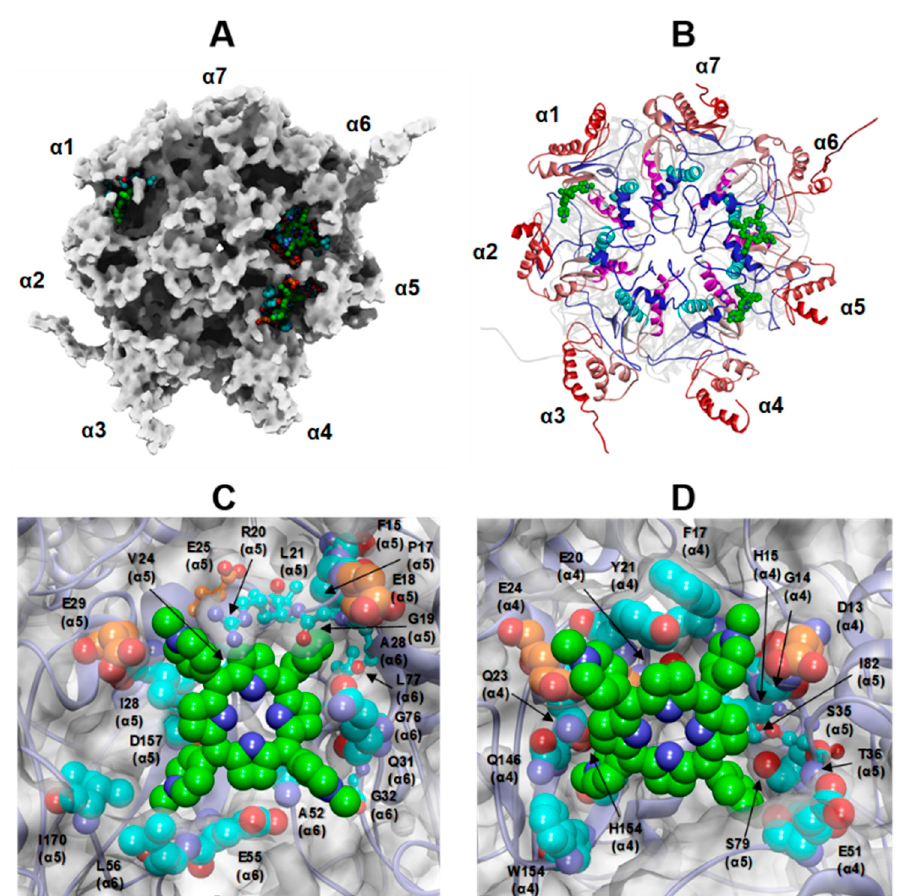
Figure 10. ( A , B ): Top view of the selected docked complex of three Tris ‐ T4 molecules bound to human 20S (open conformation). ( A ): the protein is displayed as Connolly surface and coloured in grey except for residues involved in interactions with Tris ‐ T4, which are displayed as CPK. ( B ): the protein is displayed in ribbons and secondary structure elements of each subunit are sequentially coloured from N- to C-terminal end ( α H0 = blue; α H1 = cyan; α H2 = magenta, α H3– α H5 = light red to dark red). C-D: Close up view on the ligand-binding site at the α 5– α 6 ( C ) and α 4– α 5 ( D ) grooves. Tris-T4 is coloured by atom type (C: green; N: blue). The residues involved in interactions with Tris-T4 are displayed in CPK and coloured: orange (negative residues involved in ionic interactions with RPs) and cyan (residues not engaged in RP interactions). The residues involved in interactions with RPs hydrophobic motif are evidenced in ball&stick.